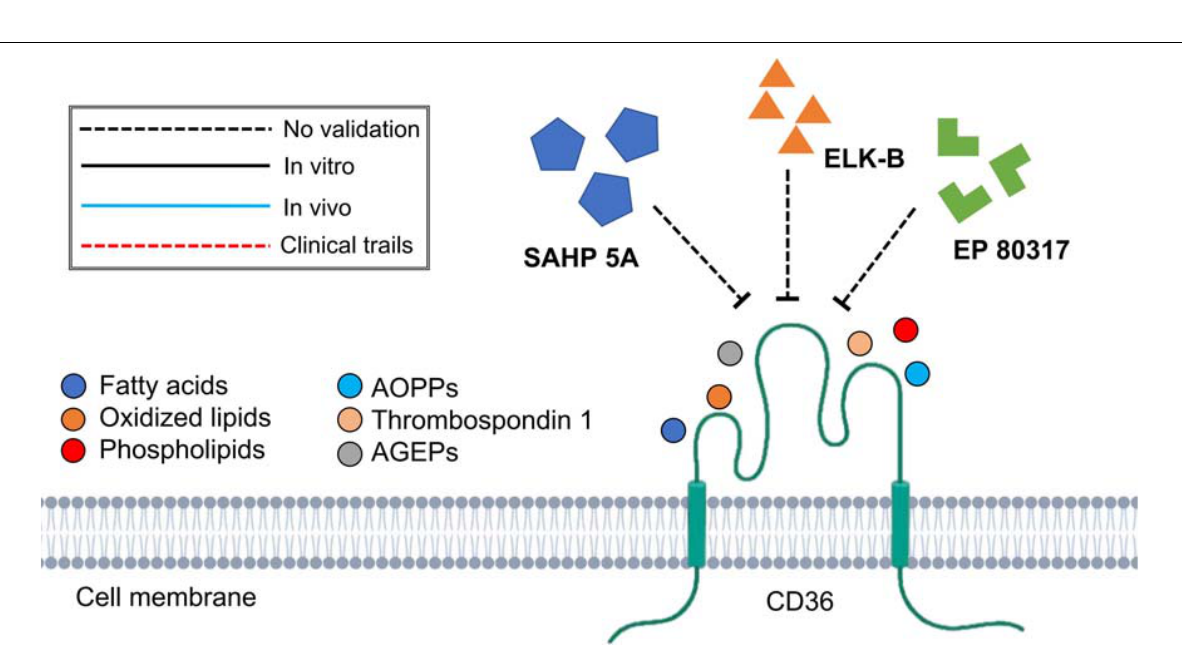
Frontiers in Physiology |